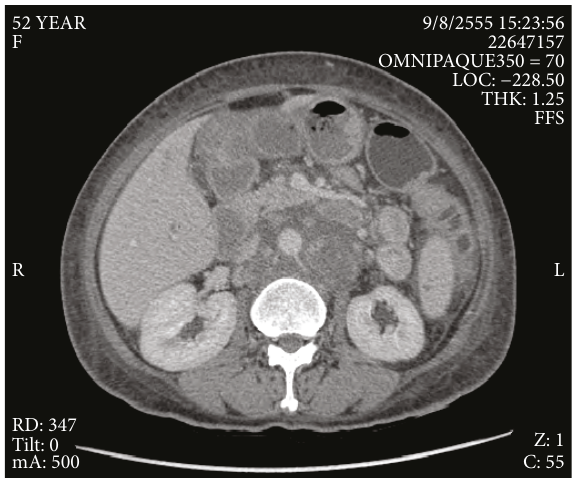
Figure 3: The following CT scan revealed a marked decrease in size of intra-abdominal lymph